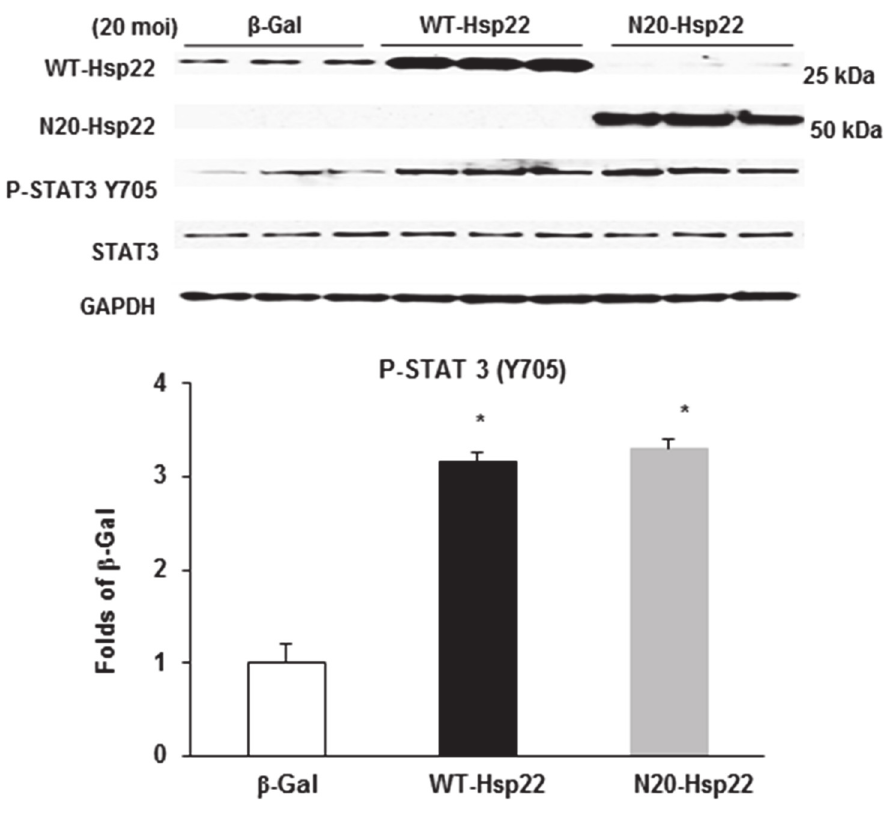
Fig 3. Regulation of gene expression of Hsp22 mutant proteins in cardiac myocytes. Immunoblotting of P-STAT3 (Y705) in myocytes treated with the β -Gal, WT-Hsp22 or N20-Hsp22 adenoviruses (20 moi). * P < 0.05 vs β -Gal, n = 6 per group.